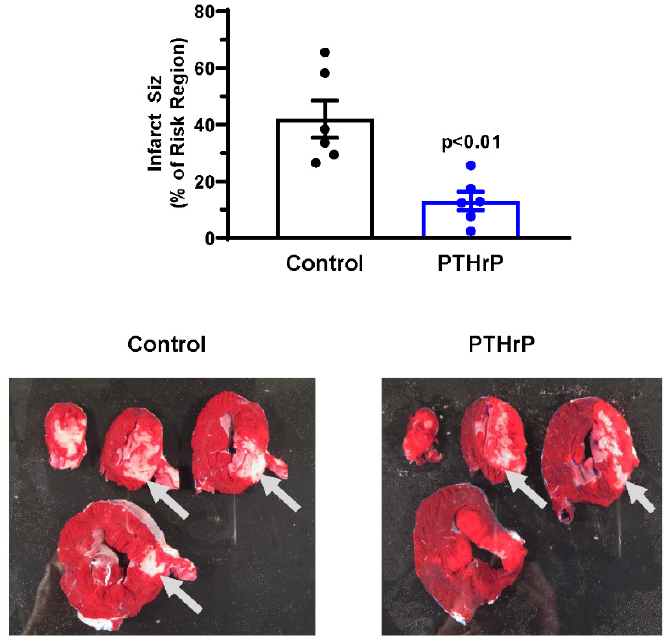
Figure 6. Myocardial infarct size in PTHrP(1-36)-treated pigs and vehicle-controls. ( Top panel ) individual data points and mean values ± SEM. ( Bottom panel ) Original images of heart slices from one control and one PTHrP(1-36)-treated pig. Heart slices are stained with triphenyltetrazolium chloride; using this method, regions of necrotic myocardium (highlighted by gray arrows) remain unstained and appear pale.